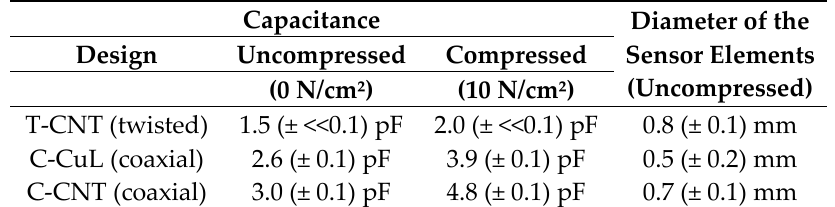
Table 1. Structure and average capacity values of different sensor element types with a length of 4 cm. The results shown refer to a measuring frequency of 100